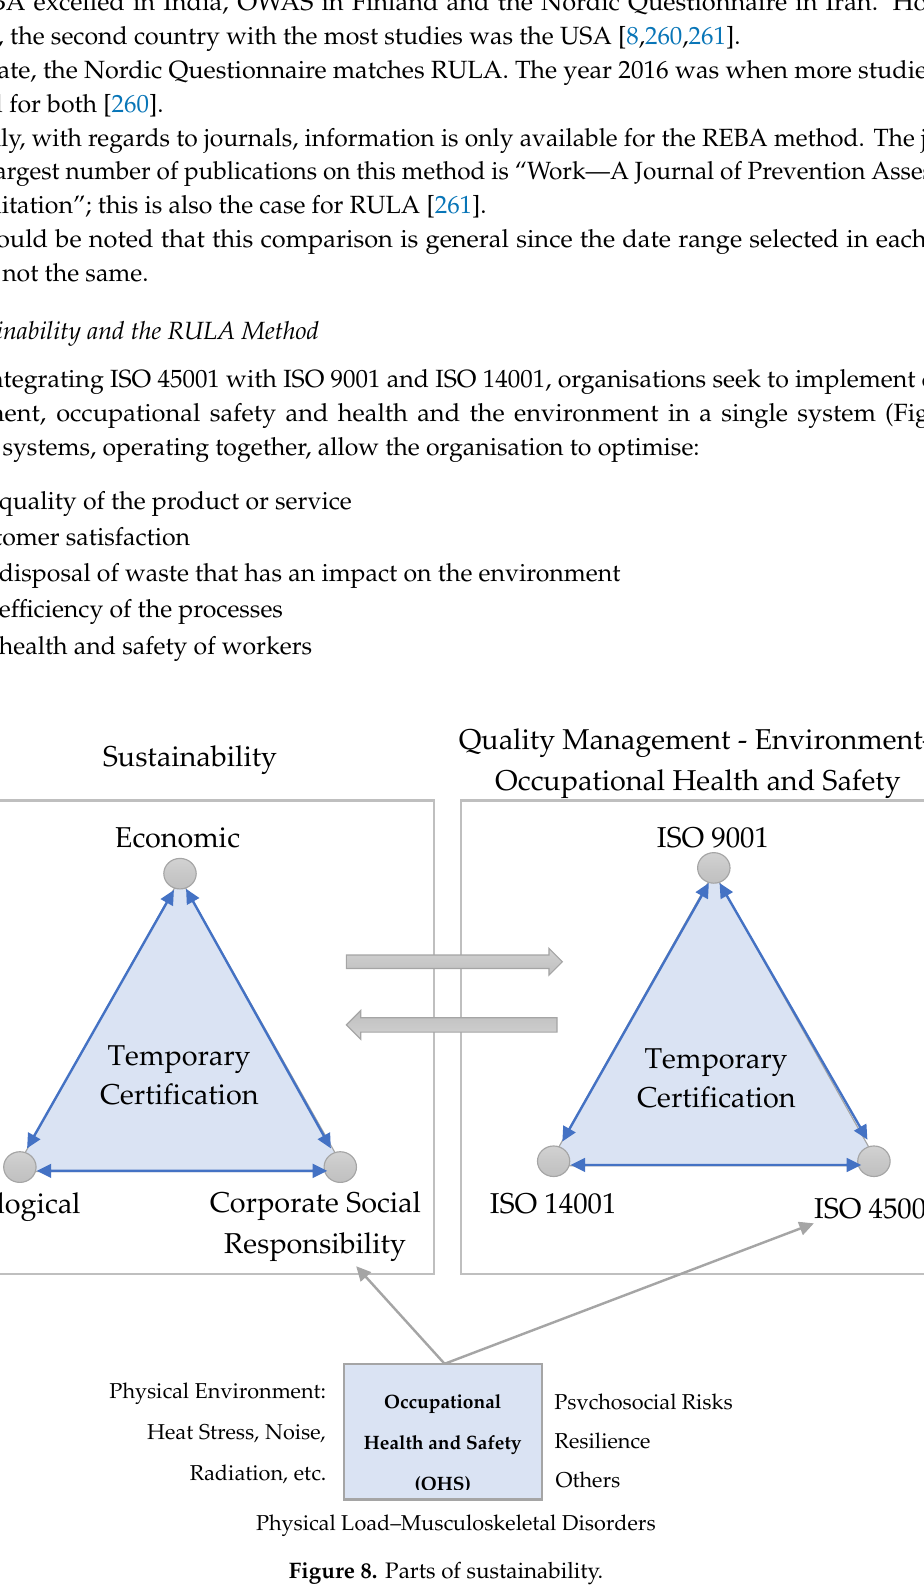
Figure 8. Parts of Figure 8. Parts of sustainability.